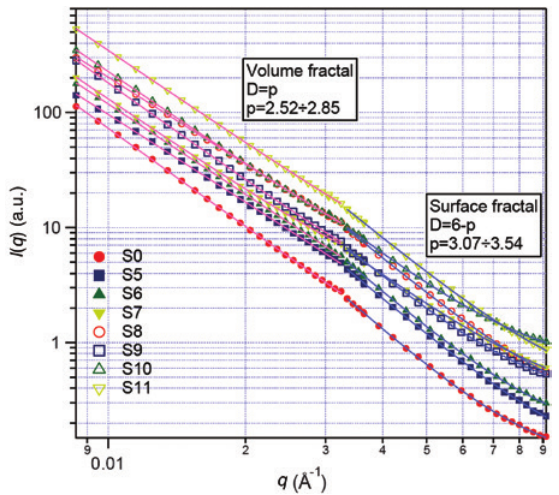
Figure 3: Averaged intensities from the SANS measurements repre- sented versus the q scattering vector. The straight lines are the fitted model curves.